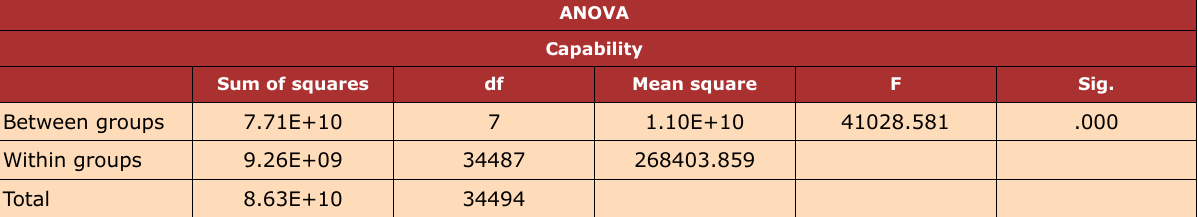
Table 3. ANOVA for all profile